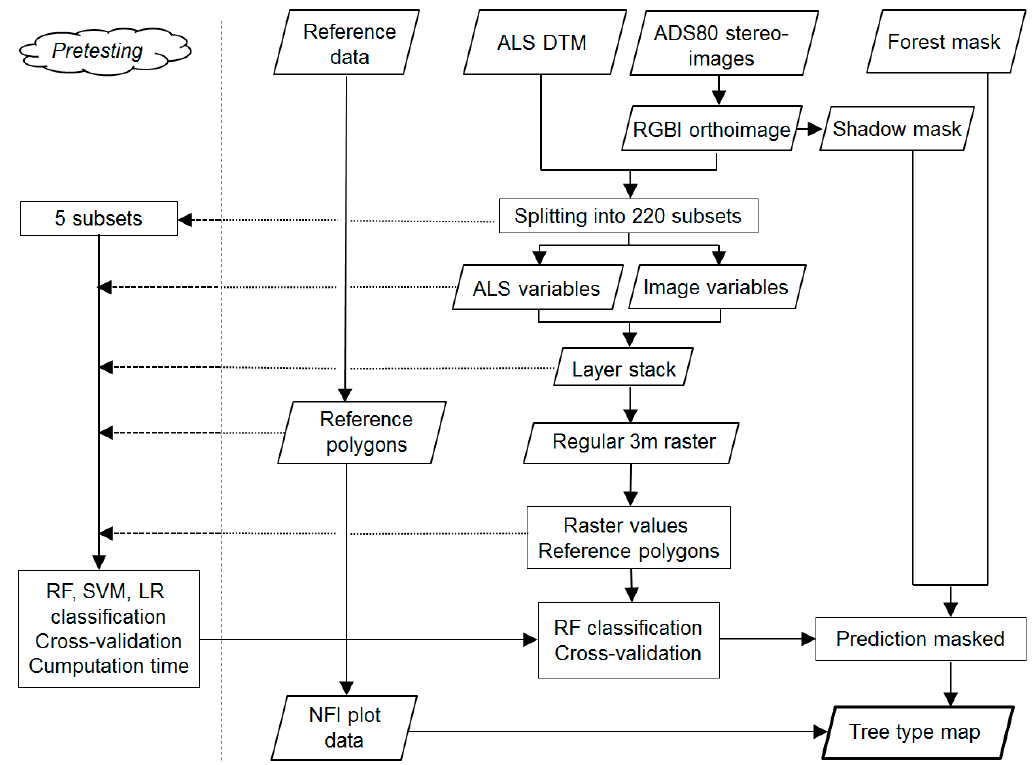
Figure 1. Workflow of the countrywide tree type classification approach.